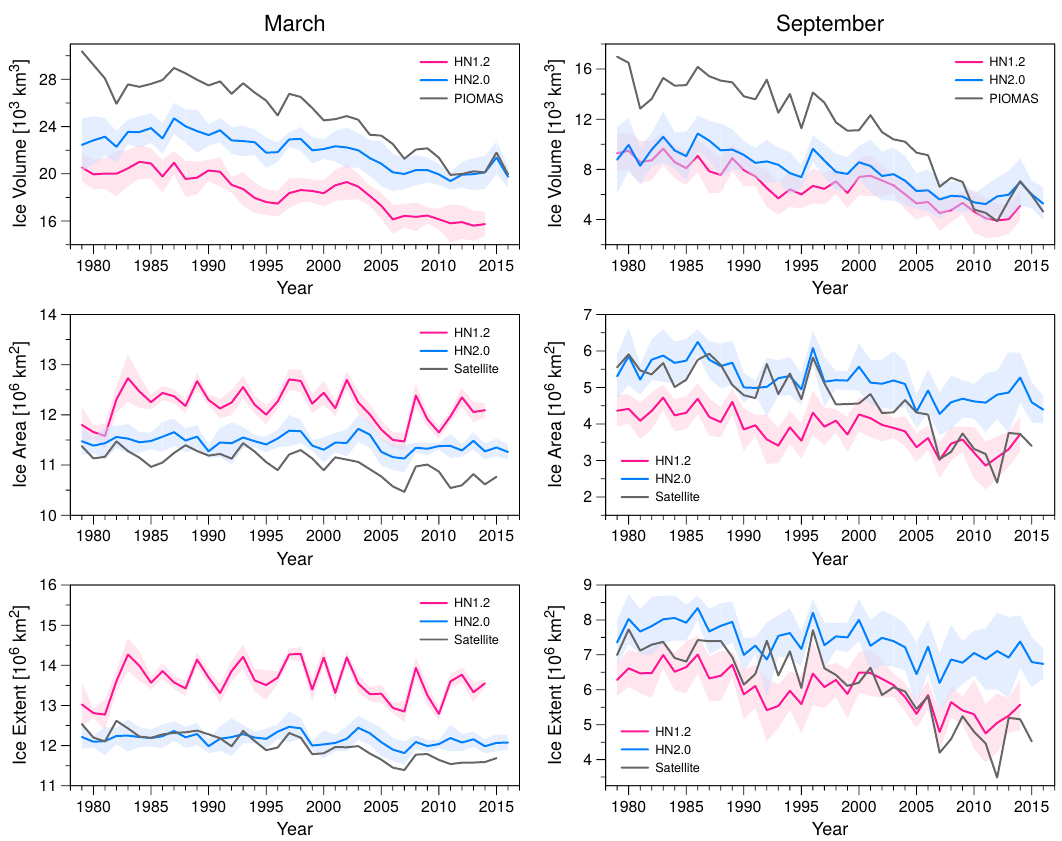
Figure 5. Temporal trends of sea-ice volume ( top ), sea-ice area ( middle ), and sea-ice extent ( bottom ) in March ( left column ) and September ( right column ) from 1979 to 2016. The red lines represent the ensemble mean of the 10-member ensemble of ERAI-driven simulations with HN1.2 and the red shaded areas the two-standard-deviation range of the ensemble. Analogously, the blue lines and blue shaded areas represent the HN2.0 ensemble. The gray lines represent sea-ice volume from PIOMAS and sea-ice area and extent from the SMMR and SSM/I-SSMIS satellite data. PIOMAS and satellite data were reduced to the NAOSIM domain. Data voids around the North Pole in the satellite data were filled with distance-weighted